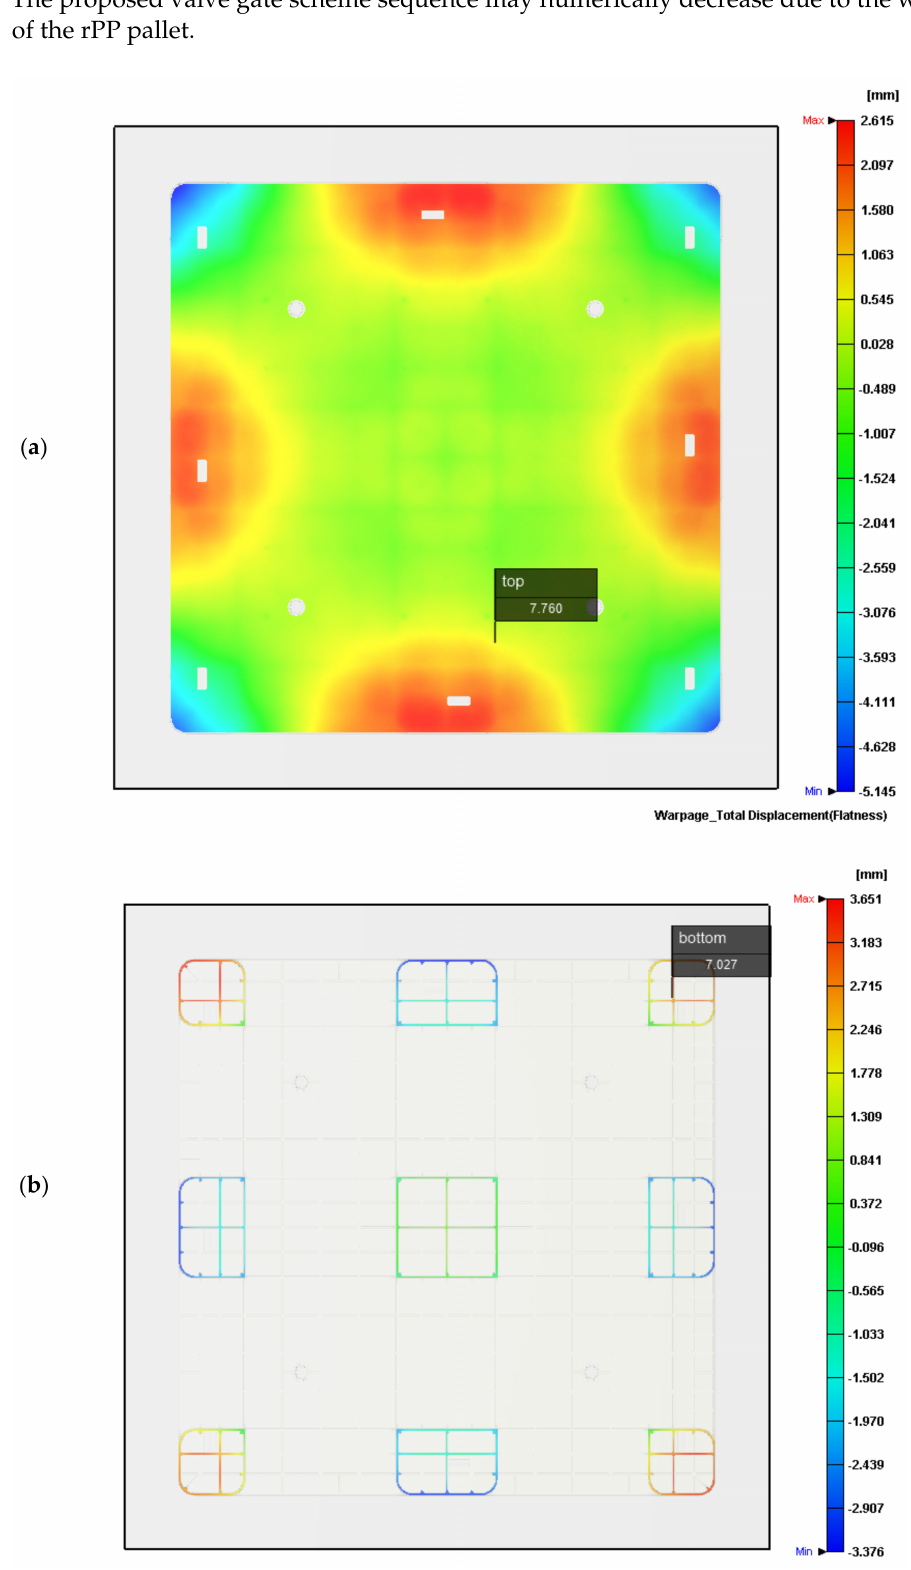
Figure 6. Flow front under the proposed sequential valve gate scheme: ( a ) Top flatness of pallet; ( b ) bottom flatness of